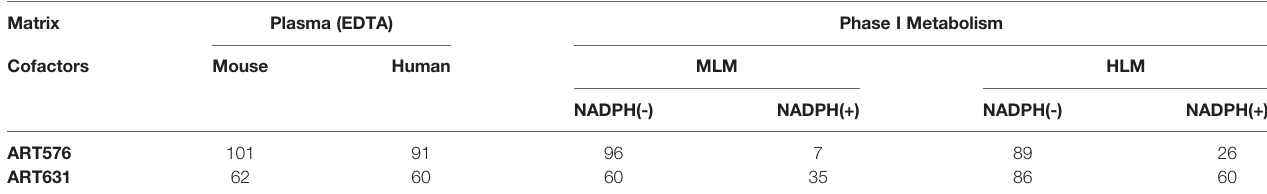
TABLE 3 | Stabilities of ARTs.